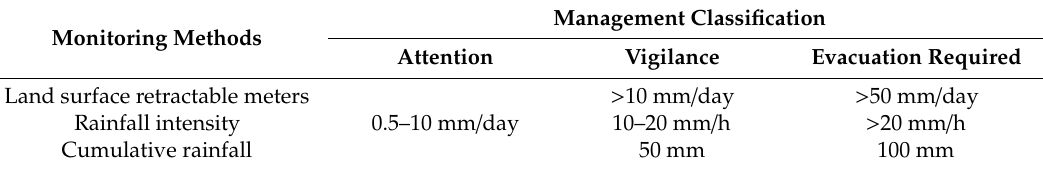
Table 3. Monitoring management benchmarks of stratum slips